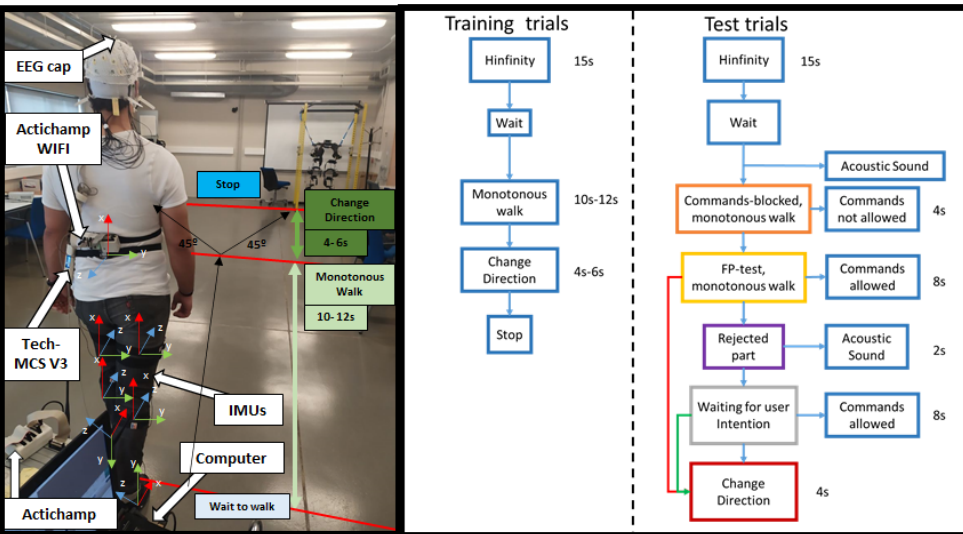
Figure 1. In the image on the left, the subject with the equipment on the day of the test. With this setup, the training and test were performed. The training and test protocol is schematized in the figure on the